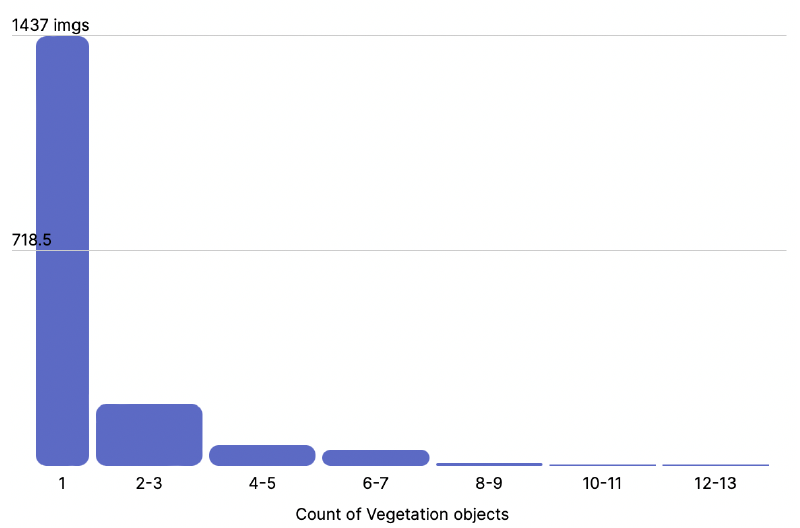
Figure 13. Distribution of vegetation objects per image.